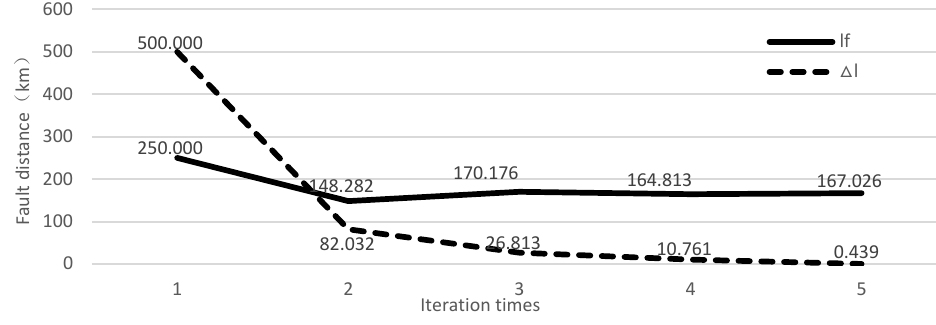
Figure 14. The results of each iteration.